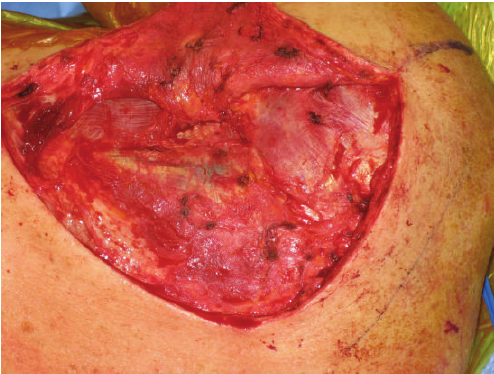
Figure 6: The curvilinear incision is positioned along the medial border of the scapula and the scapular spine.